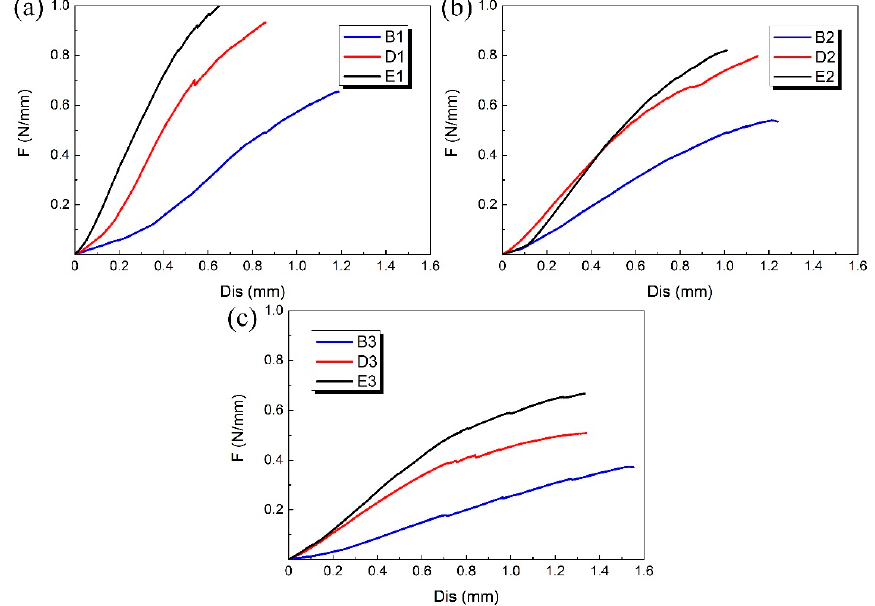
Figure 9. Radial force (per unit length) versus radial displacement curves for different geometric parameters of arrowhead NPR structure of 3D-printed PLA vascular stents: ( a ) PLA vascular stents with 12 mm stent diameter; ( b ) PLA vascular stents with 15 mm stent diameter; ( c ) PLA vascular stents with 18 mm stent diameter.